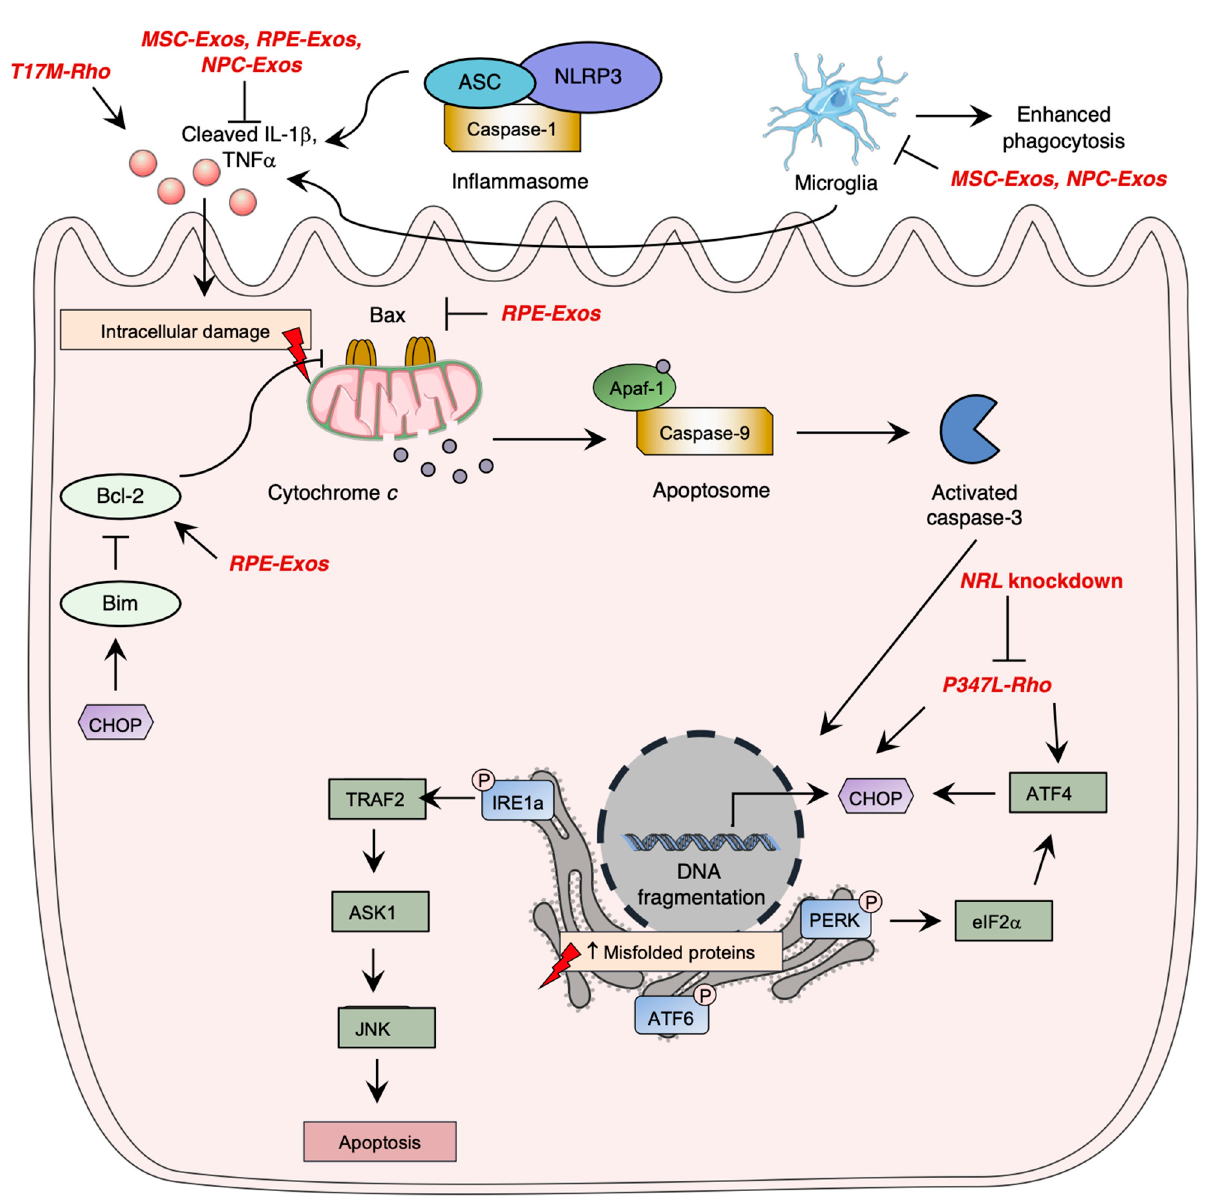
Figure 3. Overview of photoreceptor cell death pathways and their alteration in retinitis pigmentosa. Photoreceptor cell death is mainly mediated by (1) the activation of the intrinsic apoptosis pathway through cytochrome c release, (2) endoplasmic reticulum (ER) stress pathway through the activation of IRE1a, PERK, or ATF6, and (3) through inflammasome activation in macrophages. Mutations in XX have shown to induced early photoreceptor cell death in retinitis pigmentosa, leading to vision loss. Rhodopsin mutations enhance CHOP expression. The Figure was partly generated using Servier Medical Art, provided by Servier, licensed under a Creative Commons Attribution 3.0